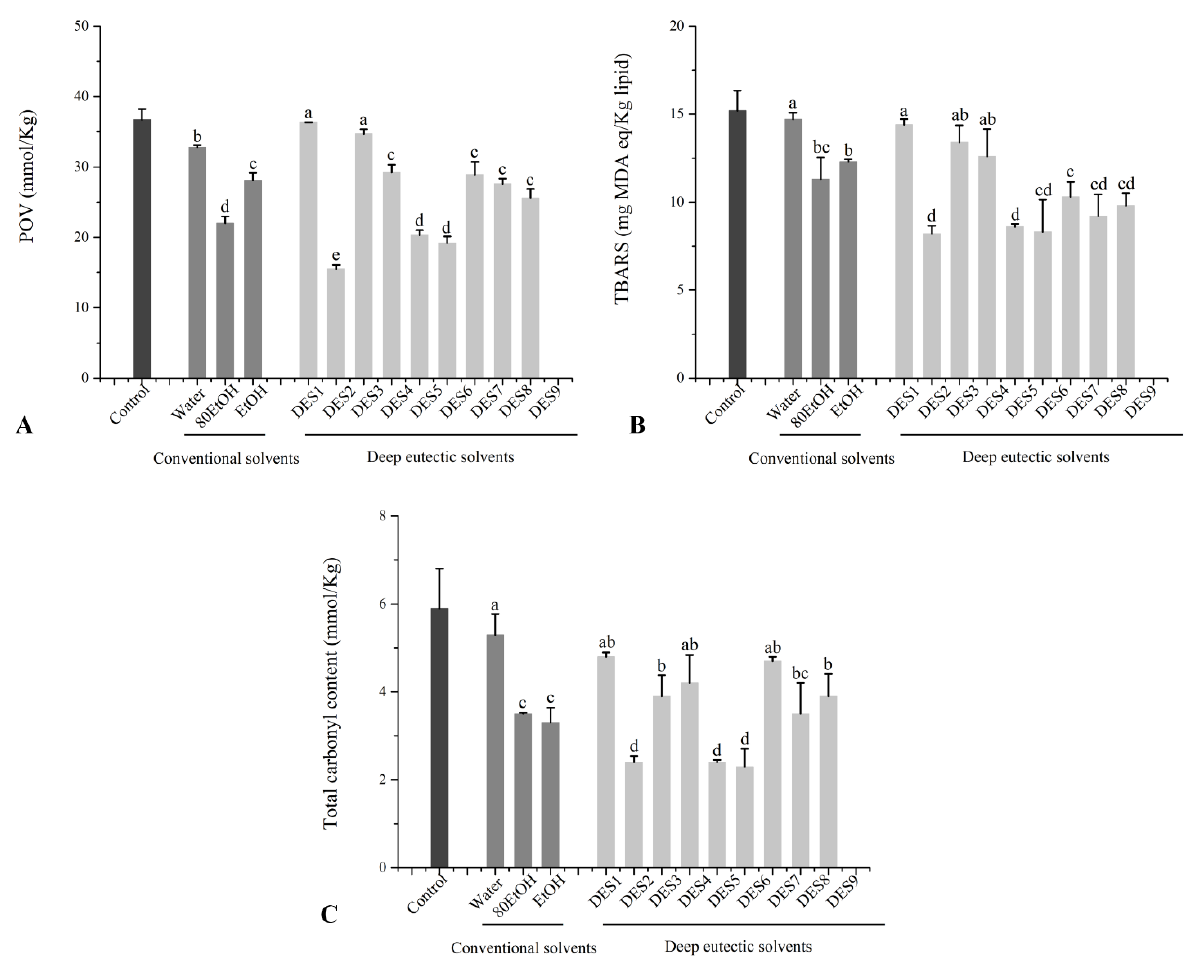
Figure 5. Effect of different ginger extract on lipid and protein oxidation of beef patties determined by ( A ) POV, ( B ) TBARS, and ( C ) total carbonyl content. The corresponding solvents’ abbreviations can be consulted in Table 1. Values are expressed as mean ± SD ( n = 3). Different letters in each series indicate significant differences ( p < 0.05); lowercase letters denote significant differences ( p < 0.05) between solvents.